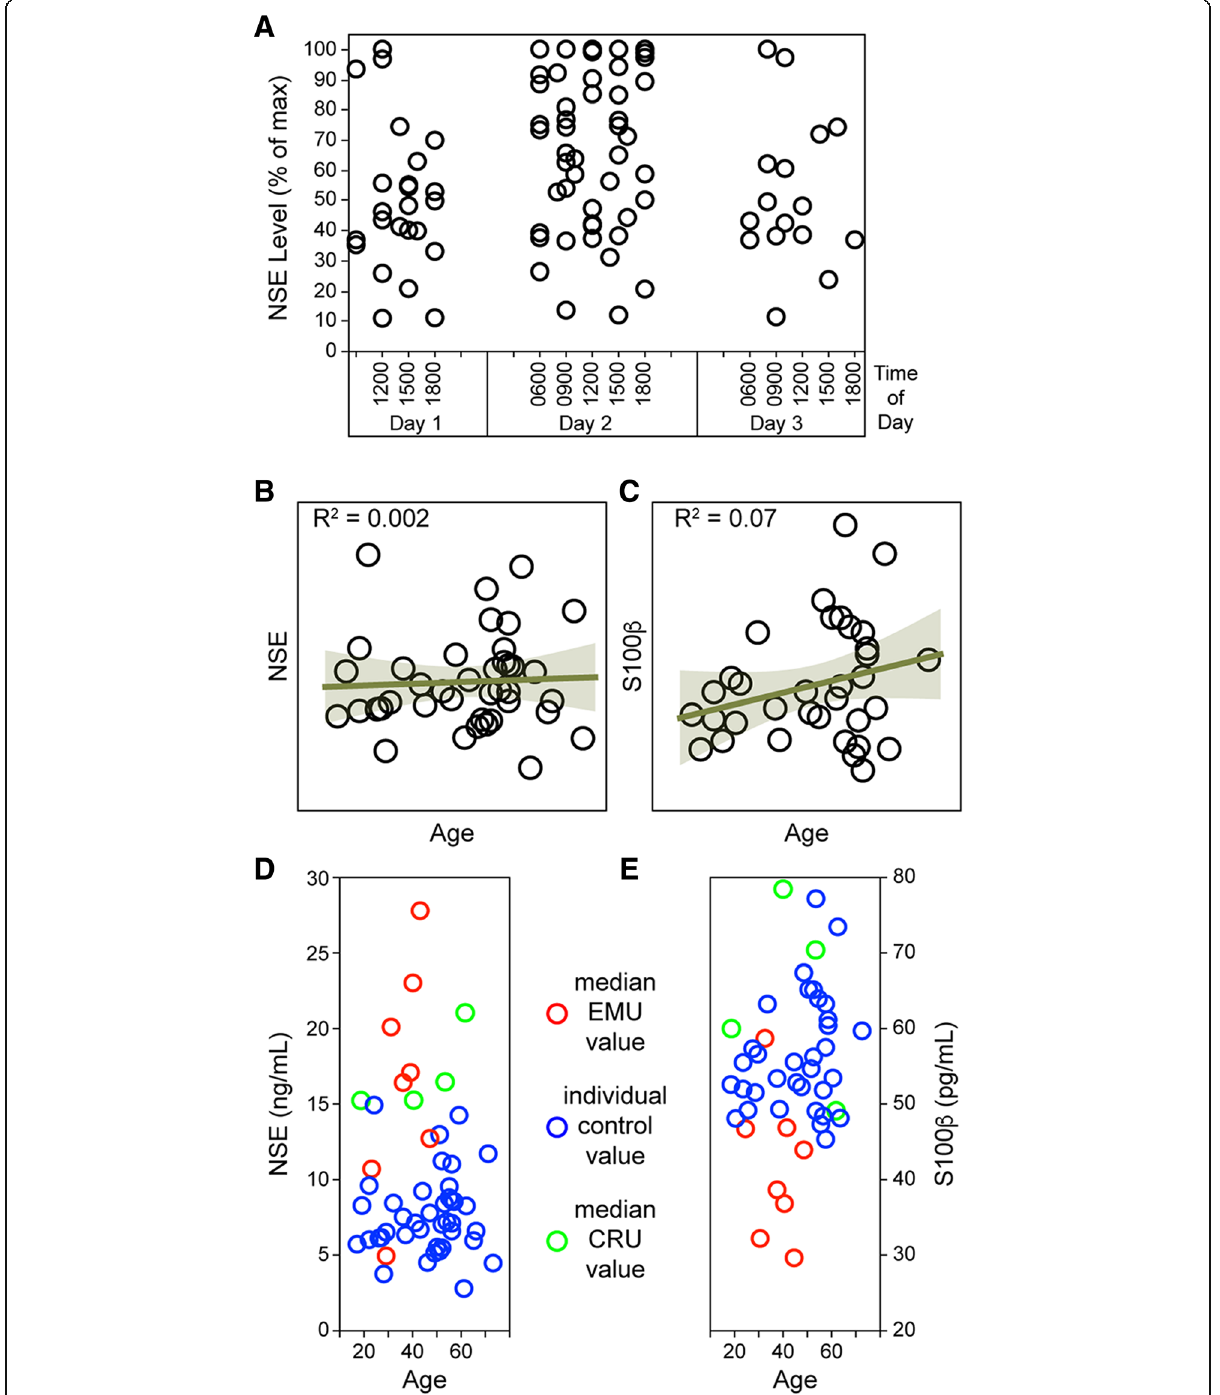
Fig. 3 NSE and S100 β levels are not associated with time-of-day or age of subject. a Each NSE measurement for all EMU and CRU subjects was converted to percent of maximum for the individual and plotted against time-of-day (CRU samples are shown on day 2 in order to capture the entire 6AM to 6PM scale). There is no apparent pattern in the distribution of maximum or minimum NSE levels, suggesting that time-of-day did not drive the variations observed in the EMU patients. b Absolute NSE values measured in 40 single-draw healthy controls were plotted against age at time of blood collection, revealing no relationship (R 2 =0.002). c S100 β levels in 34 single-draw healthy control subjects were also not correlated with age (R 2 =0.07). d The median NSE level for each individual EMU (red) and CRU (green) subject was also plotted against age and overlaid with the single sample healthy control values (blue). Again, no apparent relationship between age and serum NSE was revealed. e Similarly, no relationship between median serum S100 β and age was apparent in EMU or CRU